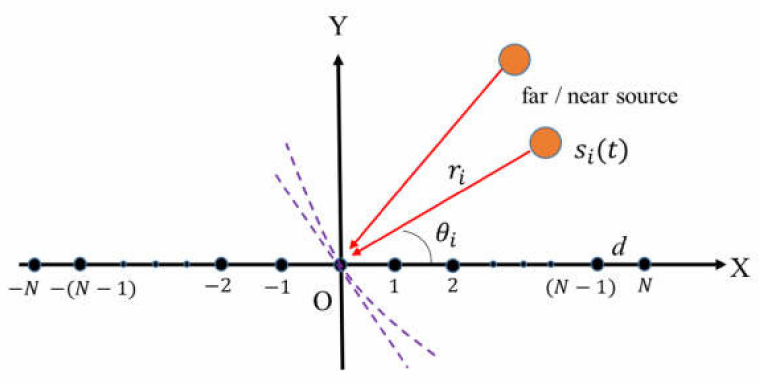
Figure 3. Mixed sources signal model of vector